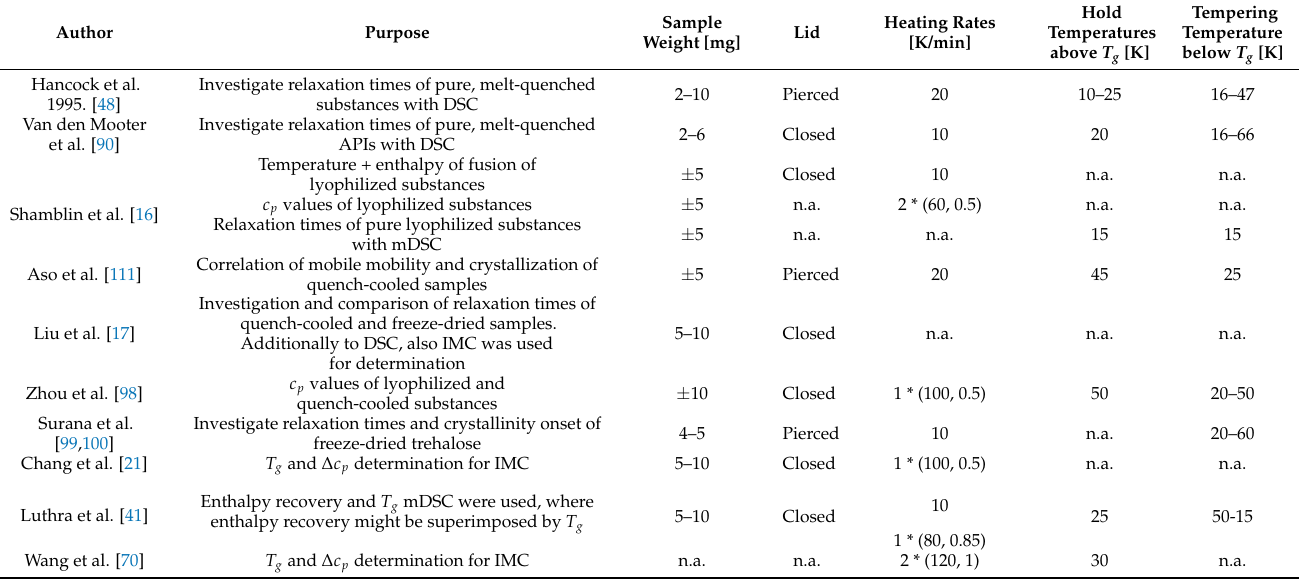
Table A1. Collection of DSC methods as suggested by different authors. n.a., not available.